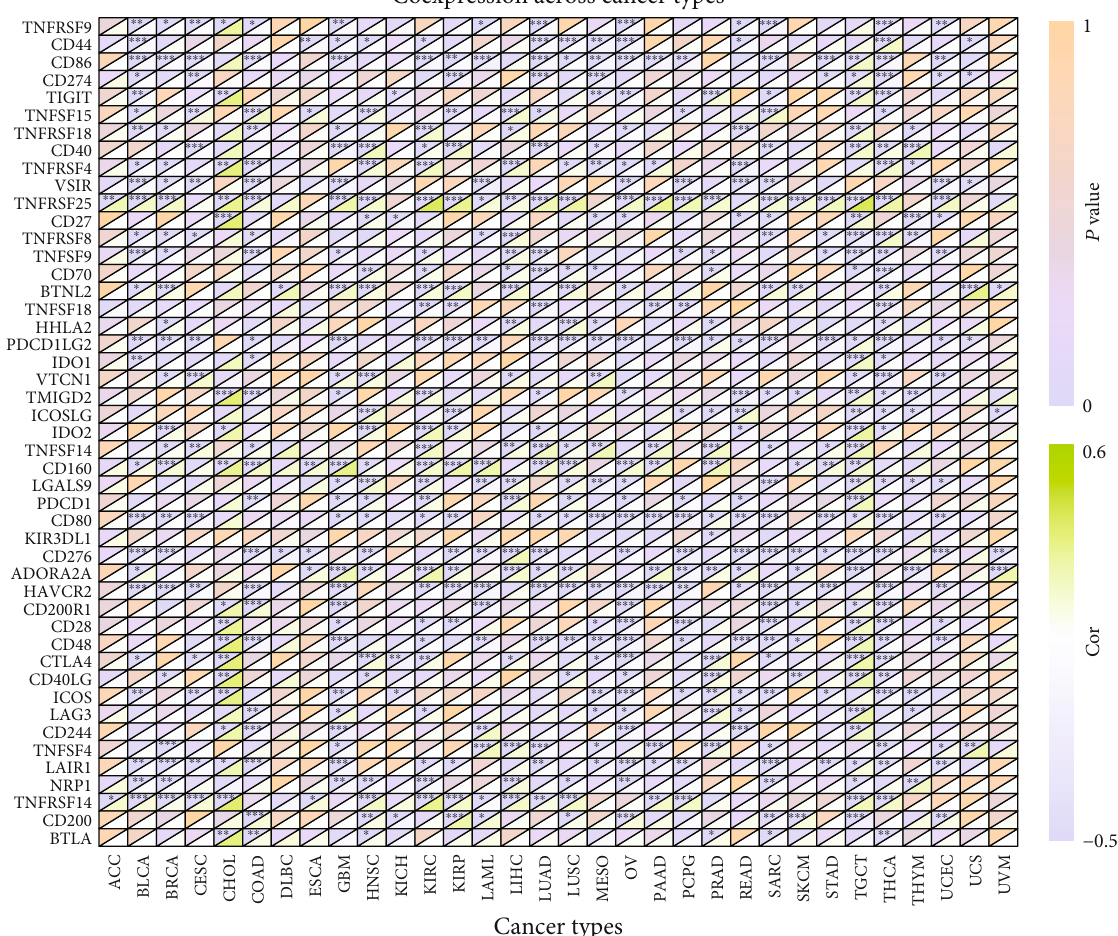
Figure 8: Heat map of correlation analysis between BACE1-AS expression and immune marker sets. ∗ P < 0 : 05 , ∗∗ P < 0 : 01 , and ∗∗∗ P < 0 : 001